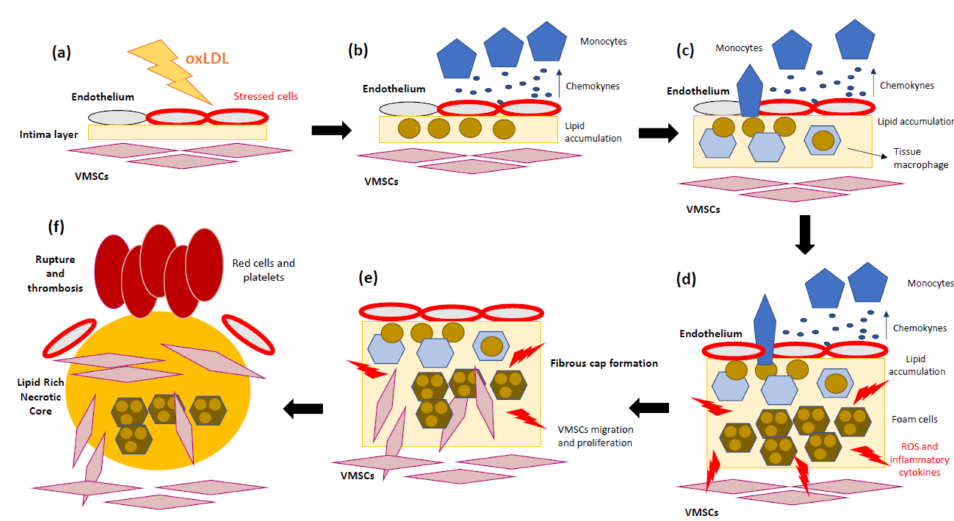
Figure 1. Schematic overview of atherosclerosis progression. ( a ) Oxidized low-density lipoprotein (oxLDL) contributes to the initial lesion in the arterial wall. ( b ) Endothelium cells produce pro-inflammatory cytokines, and circulating monocytes are recruited. ( c ) Monocytes migrate into the intima and differentiate into tissue macrophages. ( d ) Once in the artery wall, macrophages engulf the excessive lipids and become lipid-laden foam cells, which can accumulate and form a fatty streak. During the complex lesion progression, foam cell lysis by apoptosis and necrosis leads to the formation of a necrotic core and, together with defective efferocytosis, leads to the amplification of the inflammatory response. ( e ) Vascular smooth muscle cells (VSMCs) migrate from the media to the intima, where they differentiate into proliferative synthetic cells that generate extracellular matrix to form the fibrous cap and hence stabilize plaques. ( f ) During later stages, the plaque can become unstable due to the inhibition of extracellular matrix (ECM) formation, particularly collagen production by VSMCs. In addition, ECM is degraded by proteases released by macrophages, resulting in an unstable lesion that can rupture and lead to